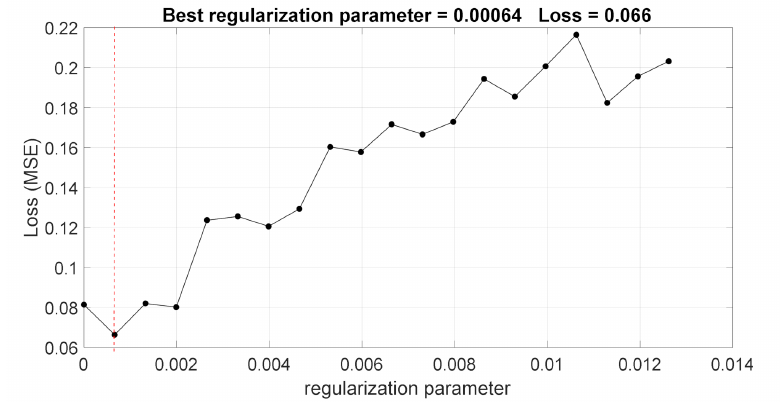
Figure 5. The average loss values versus the regularization parameter for the NCA